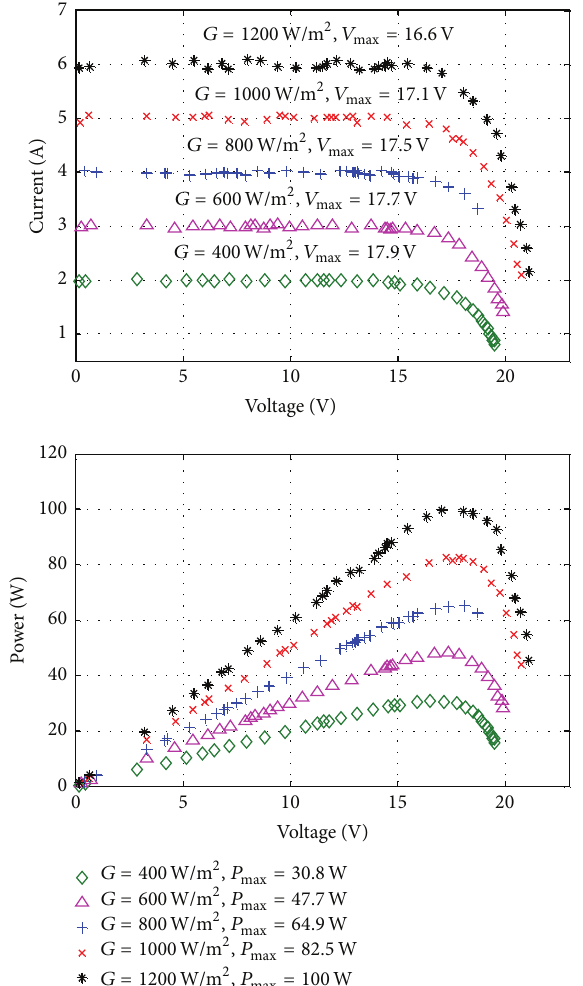
Figure 3: I - V and P-V characteristic of the PV panel at 𝑇 = 25.15 ∘